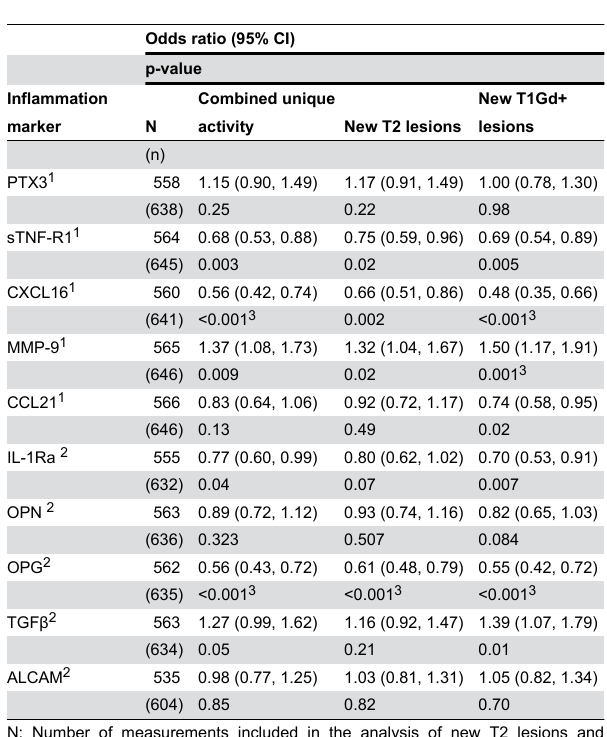
Table 4. Odds ratio for subsequent MRI activity for 1 SD increase in each inflammation marker (MRI outcomes lagged by one